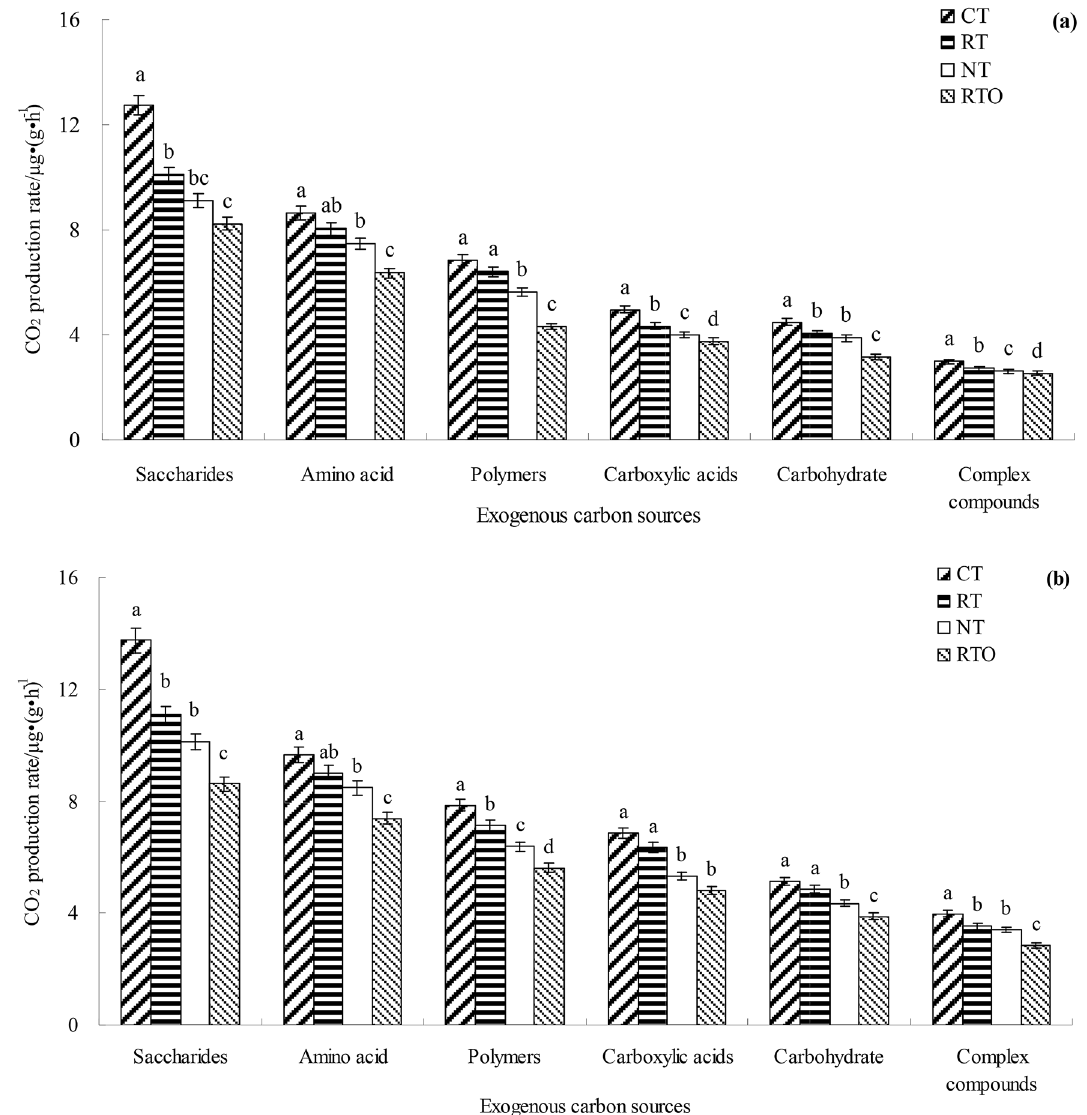
Figure 3. Characteristics of utilization of different type of exogenous carbon source by rhizosphere and non- rhizosphere soils microorganism with different tillage treatments. ( a ) Rhizosphere soils. ( b ) Non-rhizosphere soils. CT conventional tillage with crop residue incorporation, RT rotary tillage with crop residue incorporation, NT no-tillage with crop residue retention, RTO rotary tillage with crop residue removed as control. Complex compounds were including thiamine, imidazole, niacin, cinnamon, coumarin, catechin and